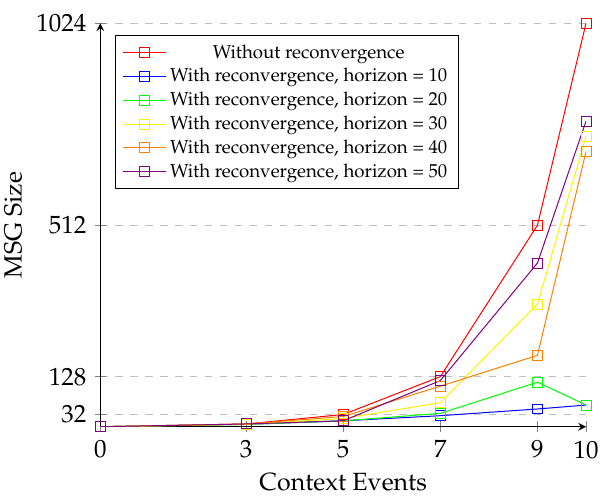
Figure 5. MSG with reconvergence for 100